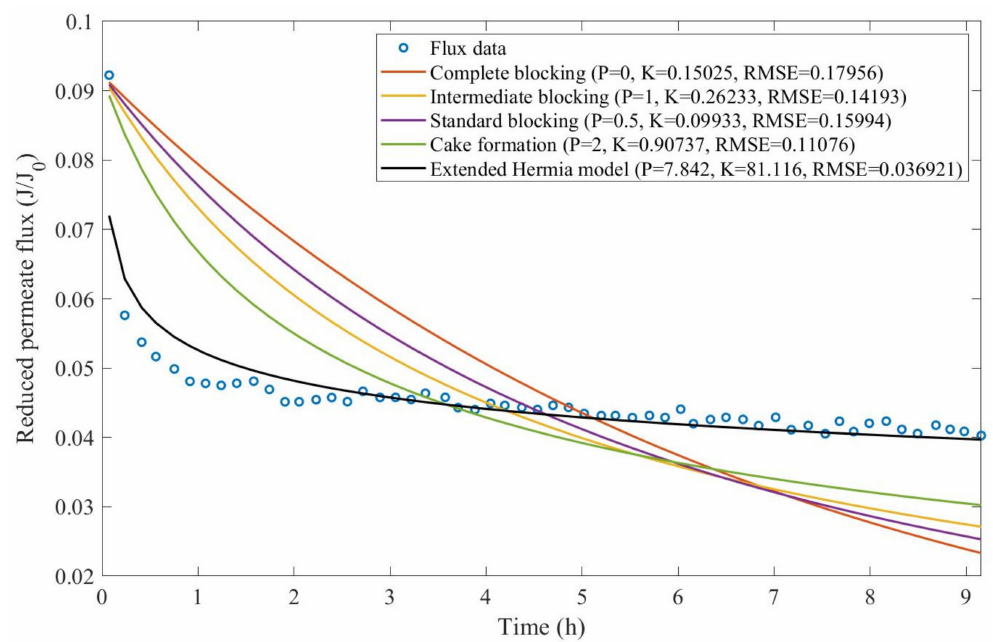
Figure A26. Model fitting for ultrafiltration of flooding wastewater at 2.20 bar and cross-flow velocity of 0.75 m/s considering the four original pore blocking mechanisms and the extended Hermia model (25).